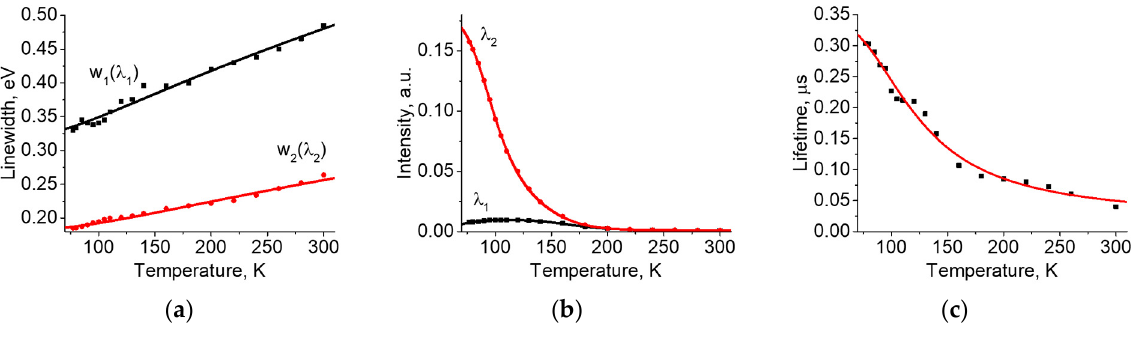
Figure 3. Temperature dependences of the ( a ) photoluminescence linewidth, ( b ) intensity, and ( c ) lifetime ( λ Ex = 455 nm and λ Em = 538 nm) of ( 1 ). Table 1. Photophysical data for the polycrystalline compound 1 .